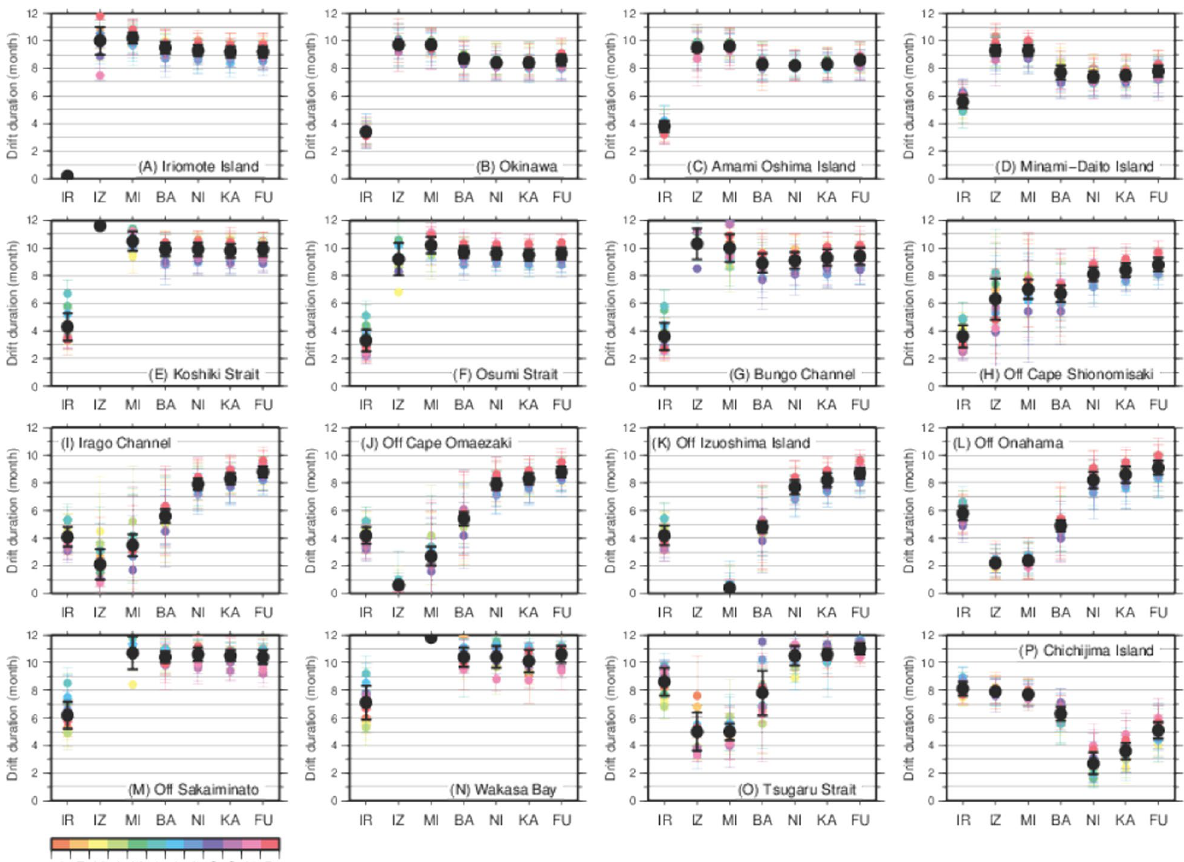
Fig. 7 Means and standard deviations (SDs) of the drift durations of virtual pumice clasts that arrived at each target area from (V1) submarine volcano NNE of Iriomote Island (IR), (V2) Izu-Tobu volcanic range (IZ), (V3) Miyakejima (MI), (V4) Bayonnaise Rocks (BA), (V5) Nishinoshima (NI), (V6) Kaitoku Seamount (KA), and (V7) Fukutoku-Oka-no-Ba (FU). Black symbols and error bars are yearly means and SDs from 1982 to 2015; colored symbols and error bars are monthly means and SDs from 1982 to